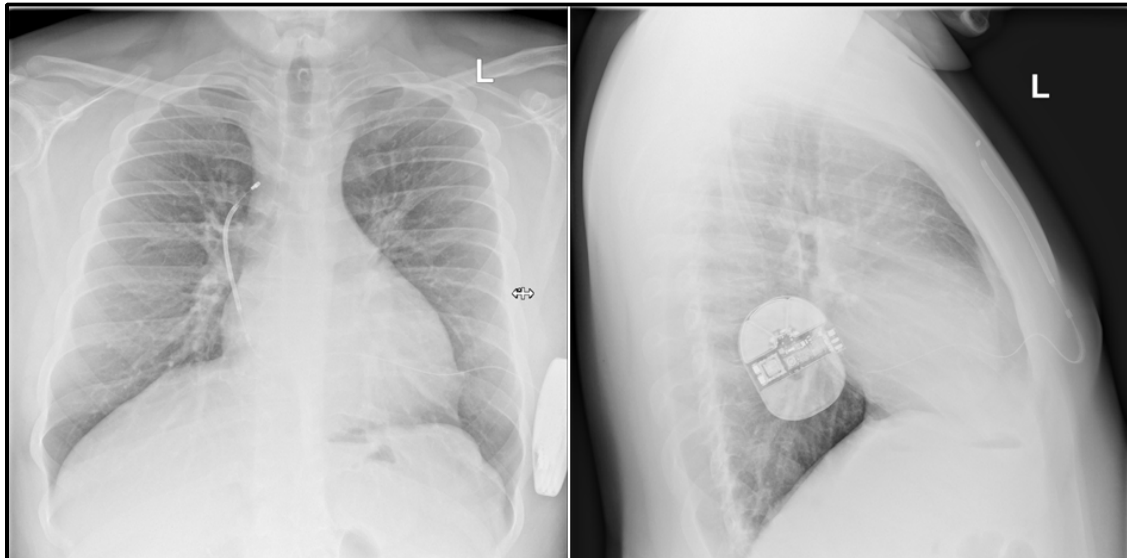
Figure 2. Patient 3. Chest X-ray of an obese patient with electrode placed on the right side of the sternum. This coil positioning is due to the patient’s composition features and obesity as well as the placement of the electrode (coil) on the right side. After implantation, vectors were obtained as during screening and a normal defibrillation test result was obtained.